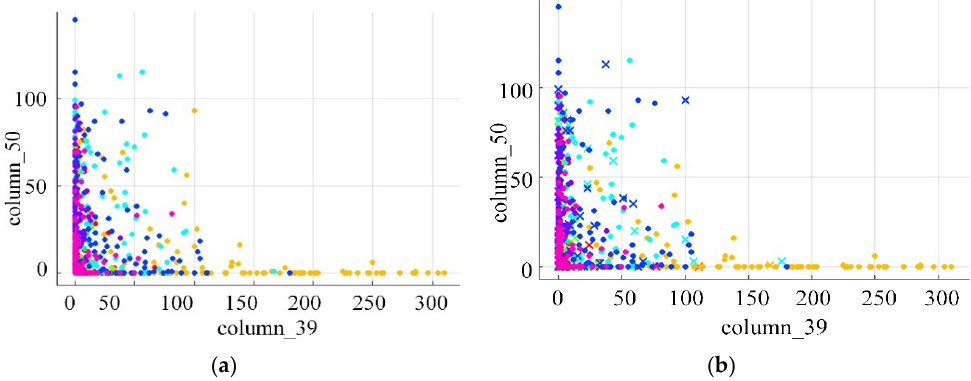
Figure 8. Display any two-dimensional classification results in Labelme. ( a ) Image data point display before entering the classifier. ( b ) Display of image prediction results in classifier.